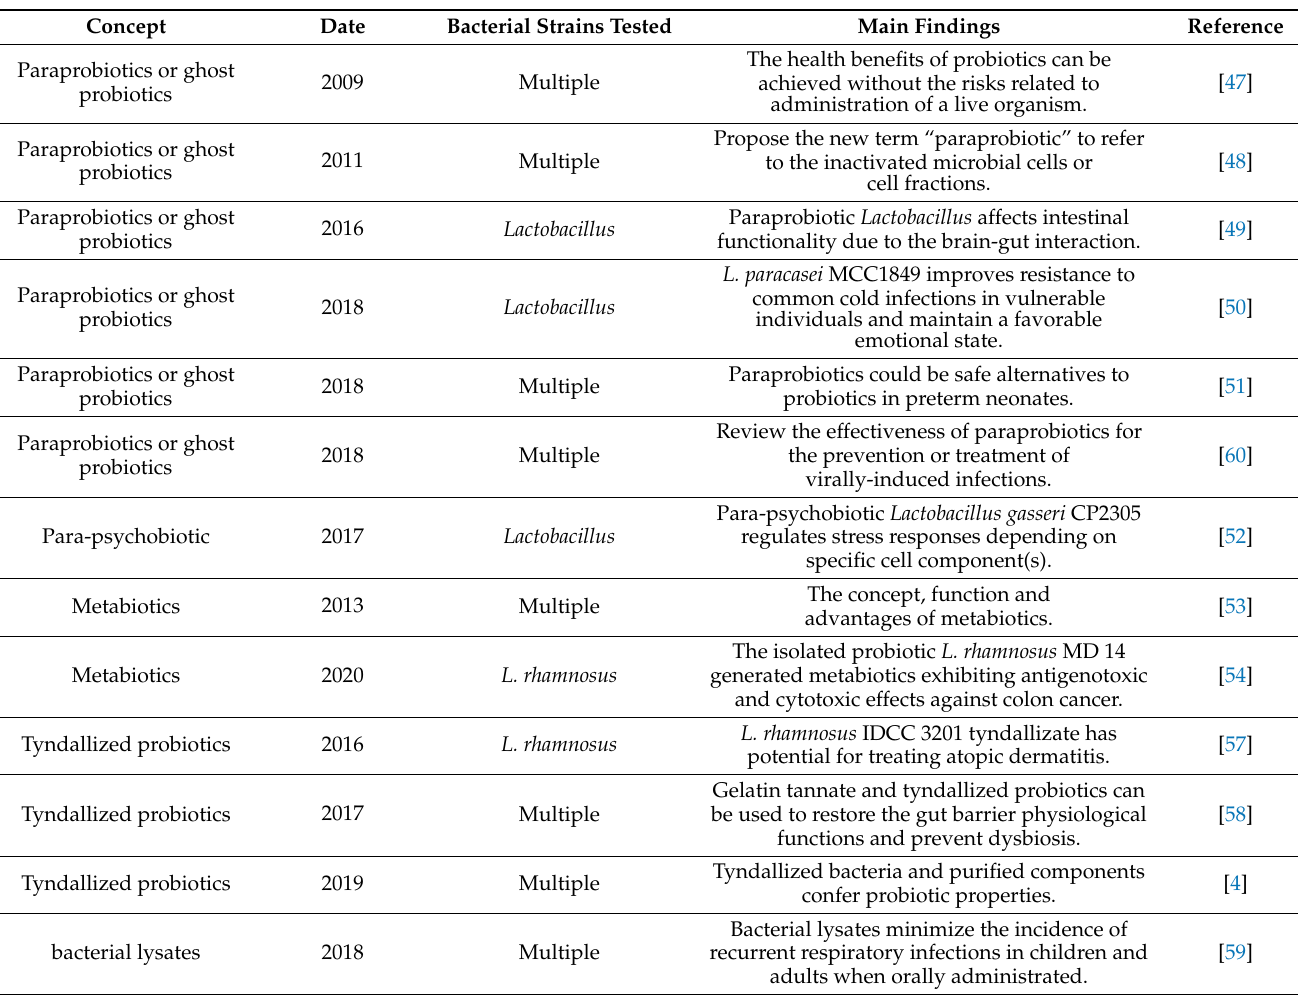
Table 1. Evolvement of the concept